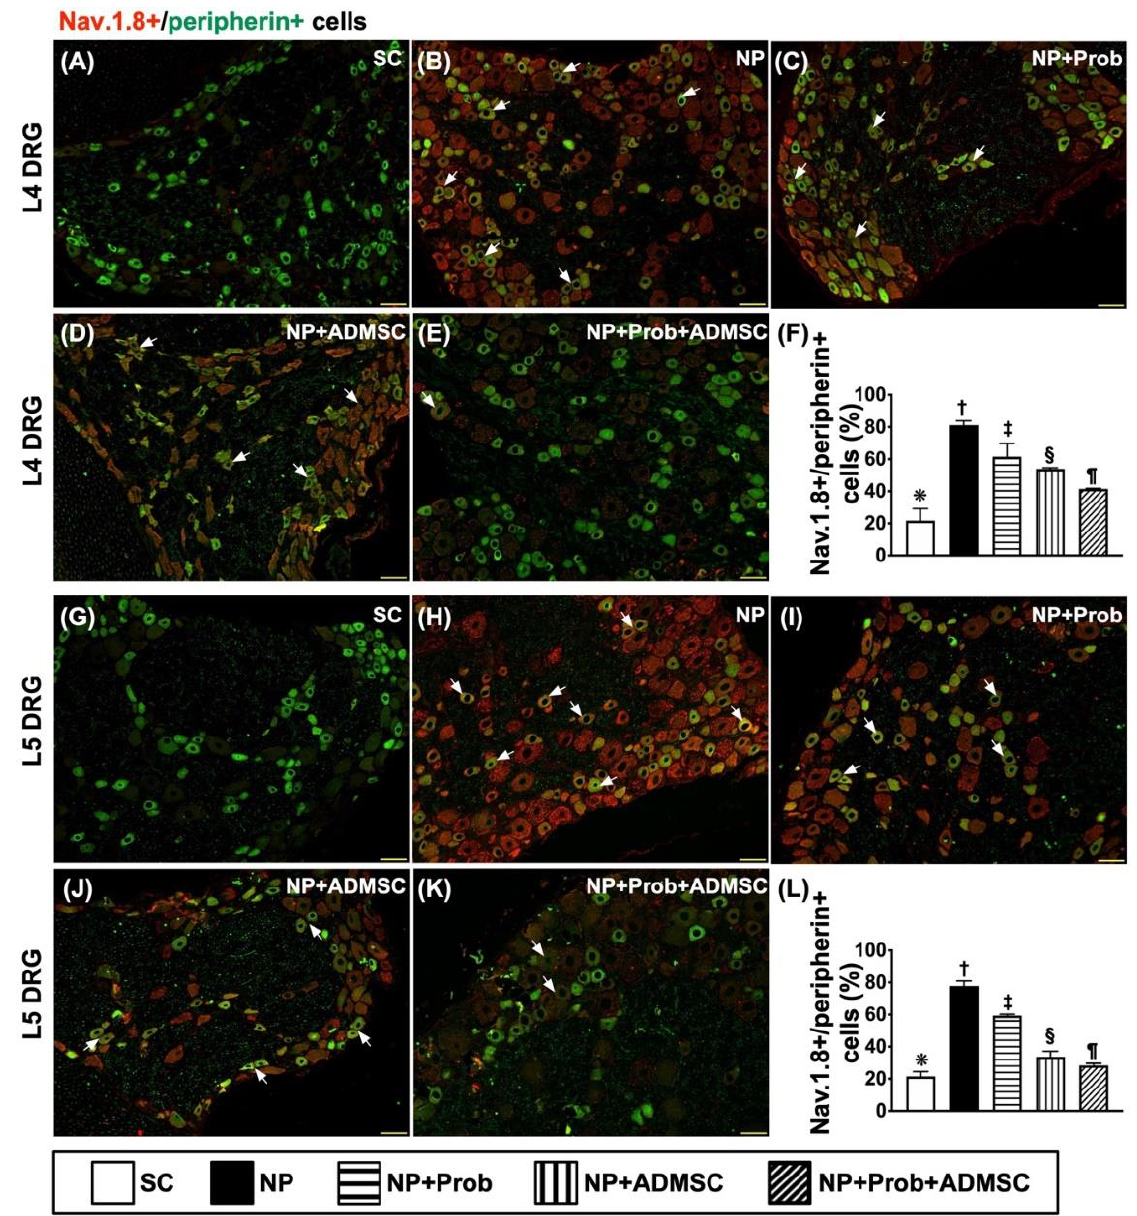
Figure 8. Cellular expressions of co-localizations between Nav.1.8 and peripherin L4-L5 DRGs neurons by day 60 after NP induction L4-DRG level: ( A – E ) Showing the immunofluorescent (IF) microscopic findings (200 × ) to identify merged positively stained Nav.1.8 and peripherin (green–red co-localization). ( F ) Analytical results of number of Nav.1.8+/peripherin+ cells, * vs. other groups with different symbols (†, ‡, §, ¶), p < 0.0001. L5-DRG level: ( G – K ) Showing IF microscopic findings (200 × ) to identify merged positively stained Nav.1.8 and peripherin (green–red co-localization). ( L ) Analytical results of number of Nav.1.8+/peripherin+ cells, * vs. other groups with different symbols (†, ‡, §, ¶), p < 0.0001. Note that the white arrows indicate the merged double stain of Nav.1.8+/peripherin+. Scale bars in the lower-right corner represent 50 µ m. Symbols (*, †, ‡, §, ¶) indicate significance for each other (at the 0.05 level). All statistical analyses were performed using one-way ANOVA followed by Bonferroni multiple comparison post hoc test (n = 8 for each group). SC = sham control; NP = neuropathic pain; Prob = probiotics; ADMSCs = adipose-tissue-derived mesenchymal stem